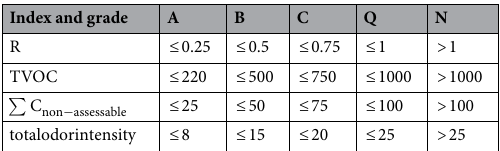
Table 1. Limit value of membership function of each